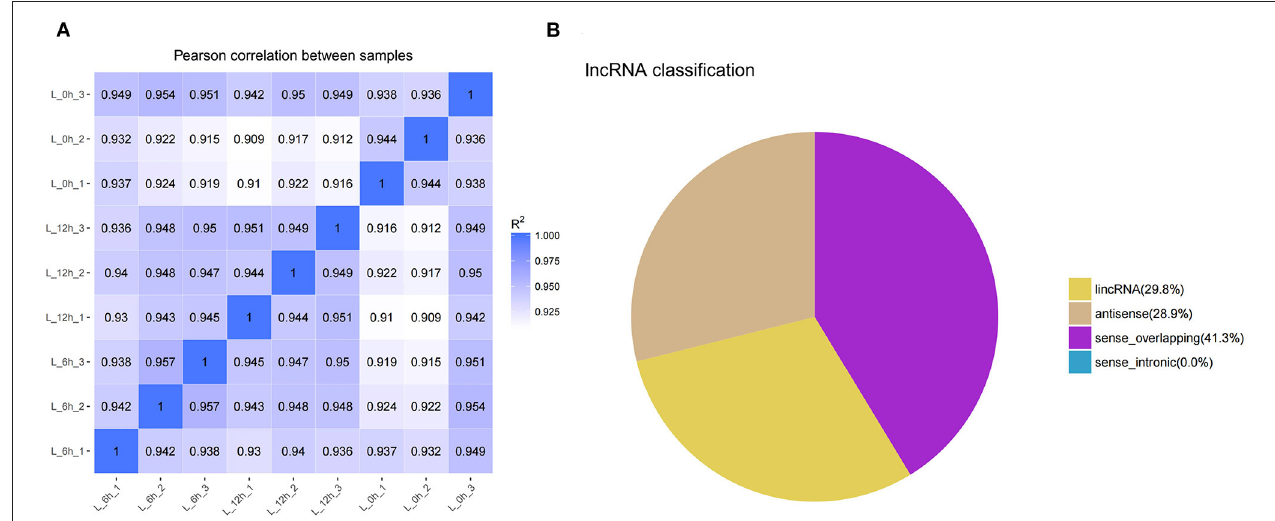
FIGURE 1 | Identification and classification of lncRNA detected in bMECs. (A) Pearson’s correlation coefficients between samples. (B) The types of novel lncRNAs. L_0h is presented that MAC-T were exposed to LPS for 0h (0h); L_6h is presented as 6 hpi; L_12h is presented as 12 hpi. (similarly hereinafter).